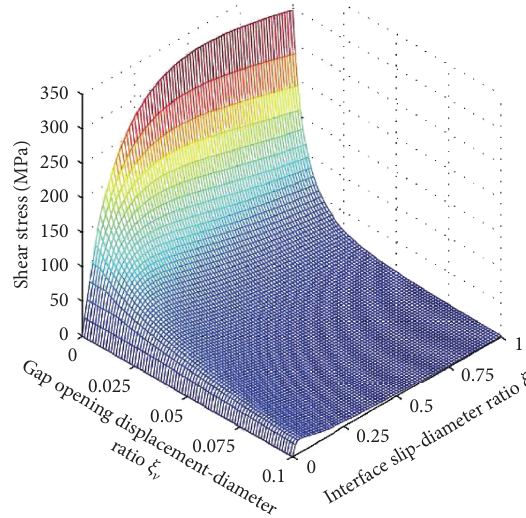
Figure 1: The space curved surface of ξ s and ξ v against shear stress of single steel bar. ξ s is the interface slip-diameter ratio; ξ v is the vertical gap opening displacement-diameter ratio.